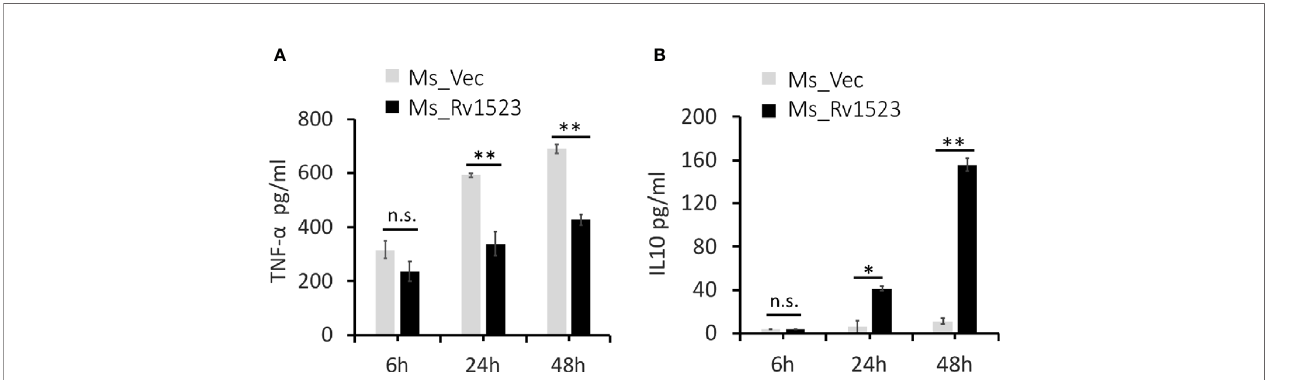
FIGURE 6 | Rv1523 modulates macrophage immune responses. Overexpression of M. tuberculosis Rv1523 in M. smegmatis modulates the immune pathway by suppressing production of pro-in fl ammatory cytokine and inducing anti-in fl ammatory cytokine production. PMA-differentiated THP-1 cells (2 × 106/well/ml) were infected with recombinant Ms_Vec and Ms_Rv1523 strains. After 6, 24, and 48 h infection, the infected cells and supernatant were collected. ELISA was used for detecting the production of TNF- a (A) and IL-10 (B) . Experiments were performed at least twice; SEM is represented by error bar for biological triplicates. Two-way ANOVA was used for determining statistical signi fi cance. ns, non-signi fi cant *p < 0.05, and **p < 0.01.